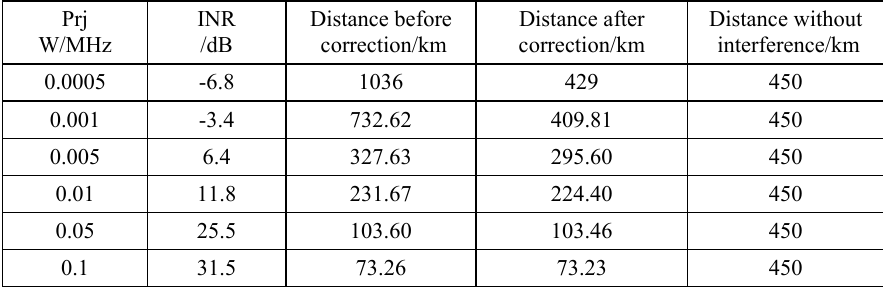
Radar detection distance (after correction) Radar maximum detection distance without jamming